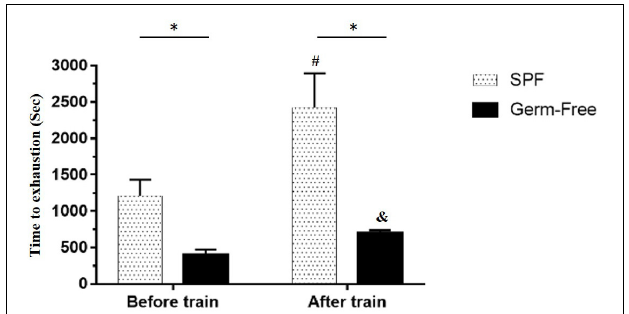
FIGURE 2 | Effect of microbiota on exercise capacity and adaption. Data are represented as mean ± SEM ( n = 8/group). ∗ P < 0.05, compared between groups. # P < 0.05, compared within SPF group. & P < 0.05, compared within GF group.